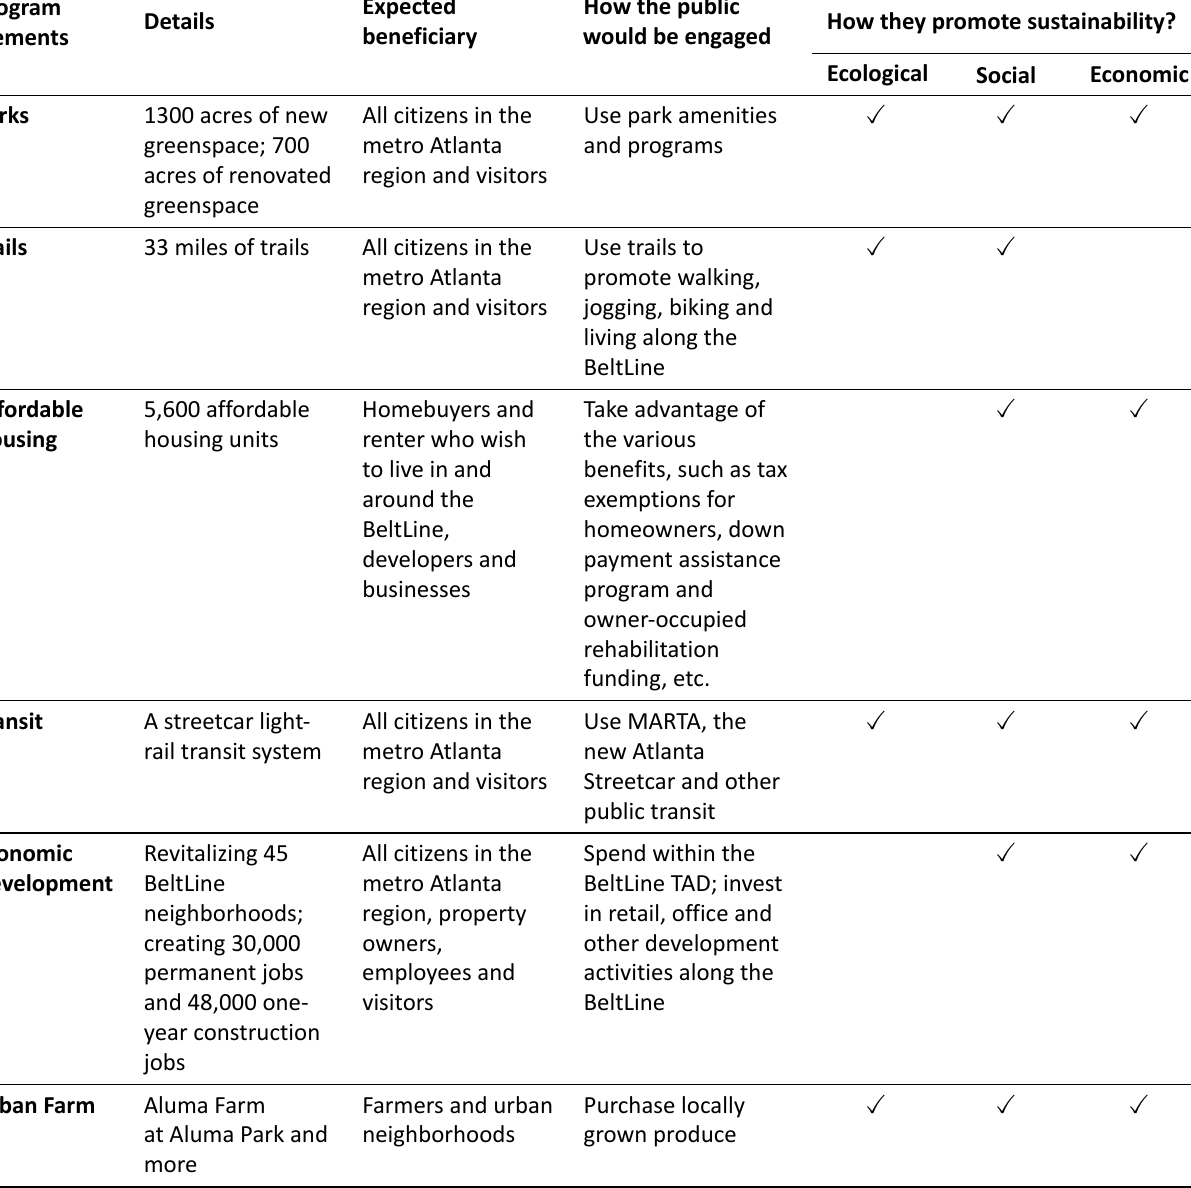
Table 1. Atlanta BeltLine program